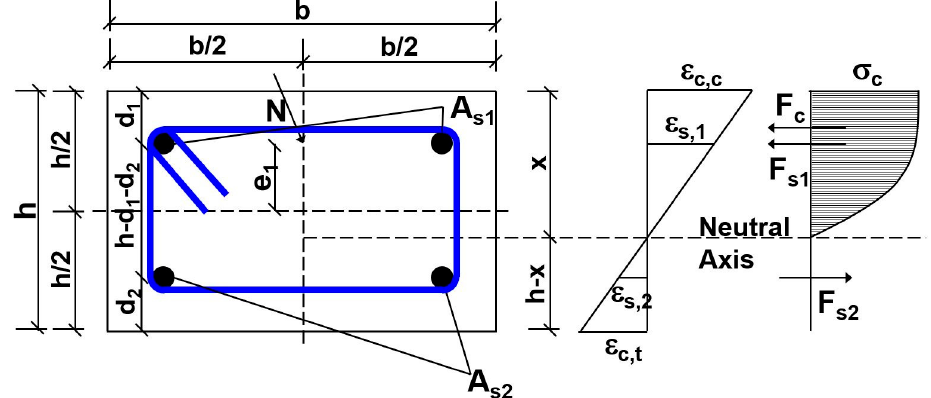
Figure 7. Column cross-section with strains, stresses and inner force